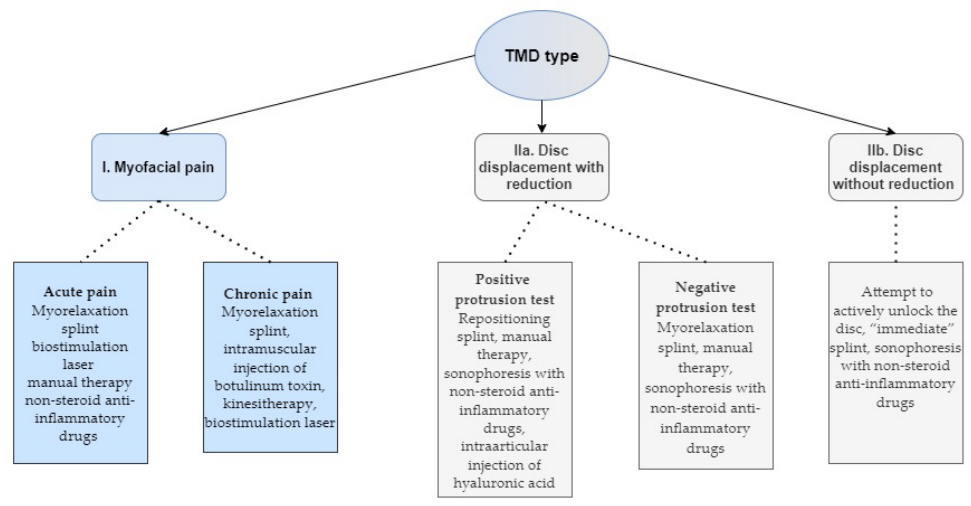
Scheme 1. Types of temporomandibular disorders and methods of